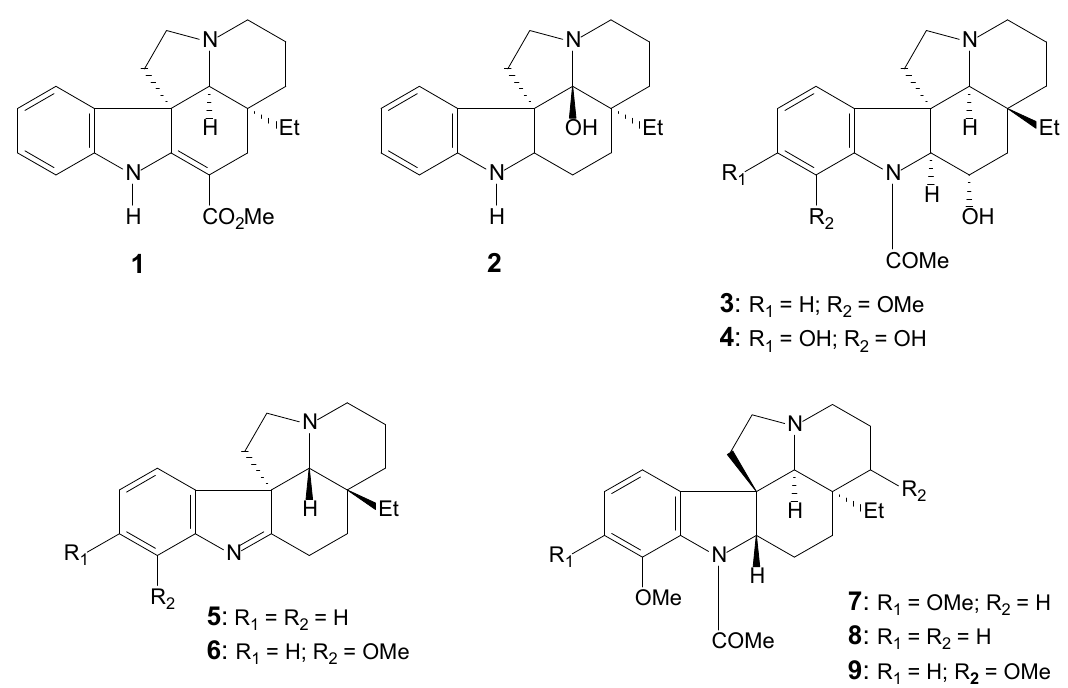
Figure 3. Plumeran indole alkaloids: methyl- β -anilineacrylate ( 1 ), fendlispermine ( 2 ), spegazzinine ( 3 and 4 ), aspidospermidine ( 5 and 6 ) and pyrifolidine ( 7 to 9 ) skeletons